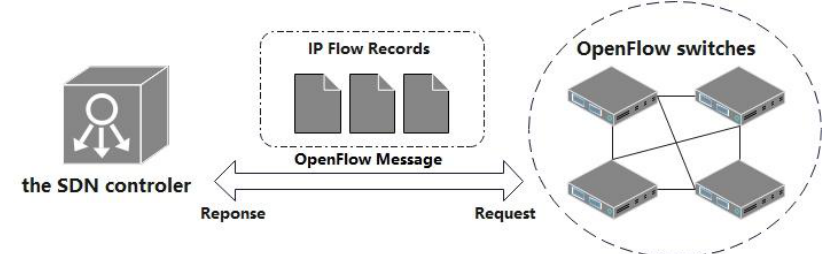
Figure 2. The process of data collection.